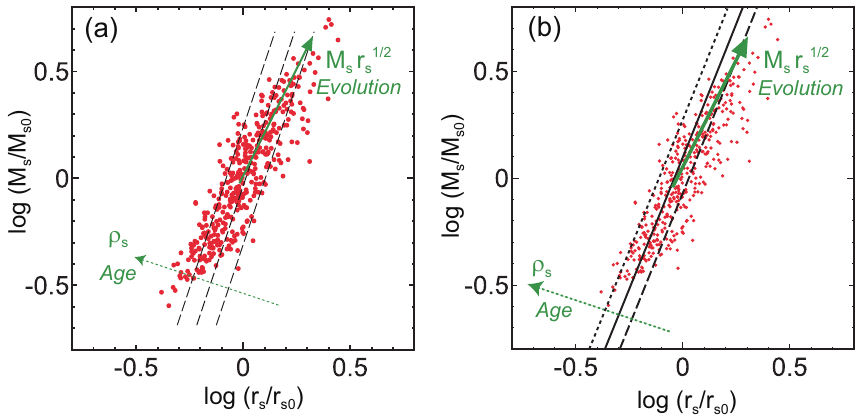
Figure 5. Projection of the fundamental plane on the log r s –log M s plane shown in Figure 3. ( a ) The red points show the MUSIC clusters ( z = 0.25) and r s 0 and M s 0 are the same as those in Figure 3. The solid arrow shows the direction of cluster evolution ( r s ∝ M 1/2 s ) and M s r 1/2 s increases in this direction. The cluster age and ρ s increase in the direction of the dotted arrow. Each dashed line satisfies ρ s = const or clusters on a particular line have the same formation redshift z f . ( b ) The same as ( a ) but M s – r s relation transformed from c ∆ – M ∆ relation is drawn (black solid line). Black dotted and dashed lines correspond to the dispersion of c ∆ – M ∆ relation ( ± 0.1 dex) shown by numerical simulations (Figures are reconstructed from Figure 5a of [23] and Figure 2 of